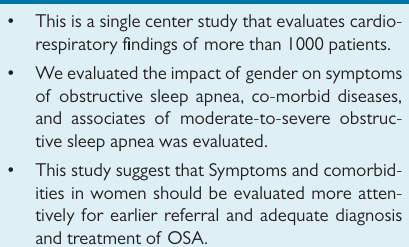
Figure 1. Flow chart of the participants evaluated in the